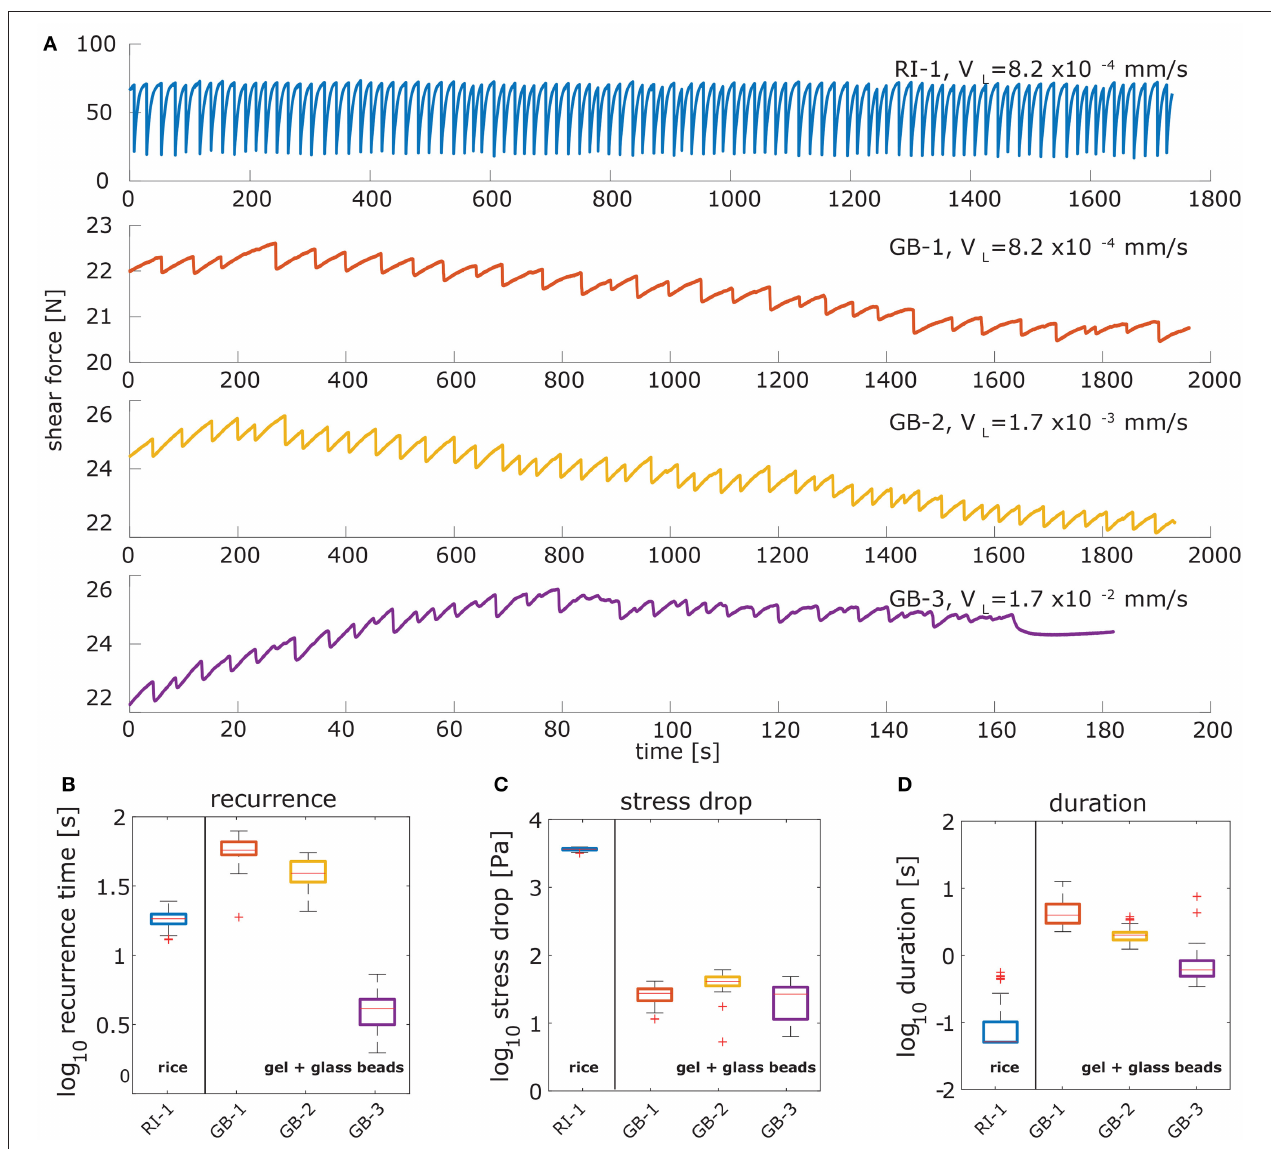
FIGURE 5 | Shear force curves and characteristic parameters derived from the stress measurements. (A) Shear force measurements during the experiments with a characteristic saw-tooth shape. The y-axis is shear force in Newton and the x-axis is time in seconds for all experiments. (B) The realized recurrence times cover two orders of magnitude and are similar for both setups. For higher shear rates the recurrence time is significantly reduced, which is in accordance with the rate-and-state-dependent friction. (C) Stress drops cover the same range for the block slider configuration and is much higher for the standard configuration. This results mostly from the stiffness of the setup, which is several orders of magnitude higher in the standard configuration. (D) The duration of the events decreases with increasing shear rate. The detected durations of the rice stick-slips are very low and truncated at 0.1